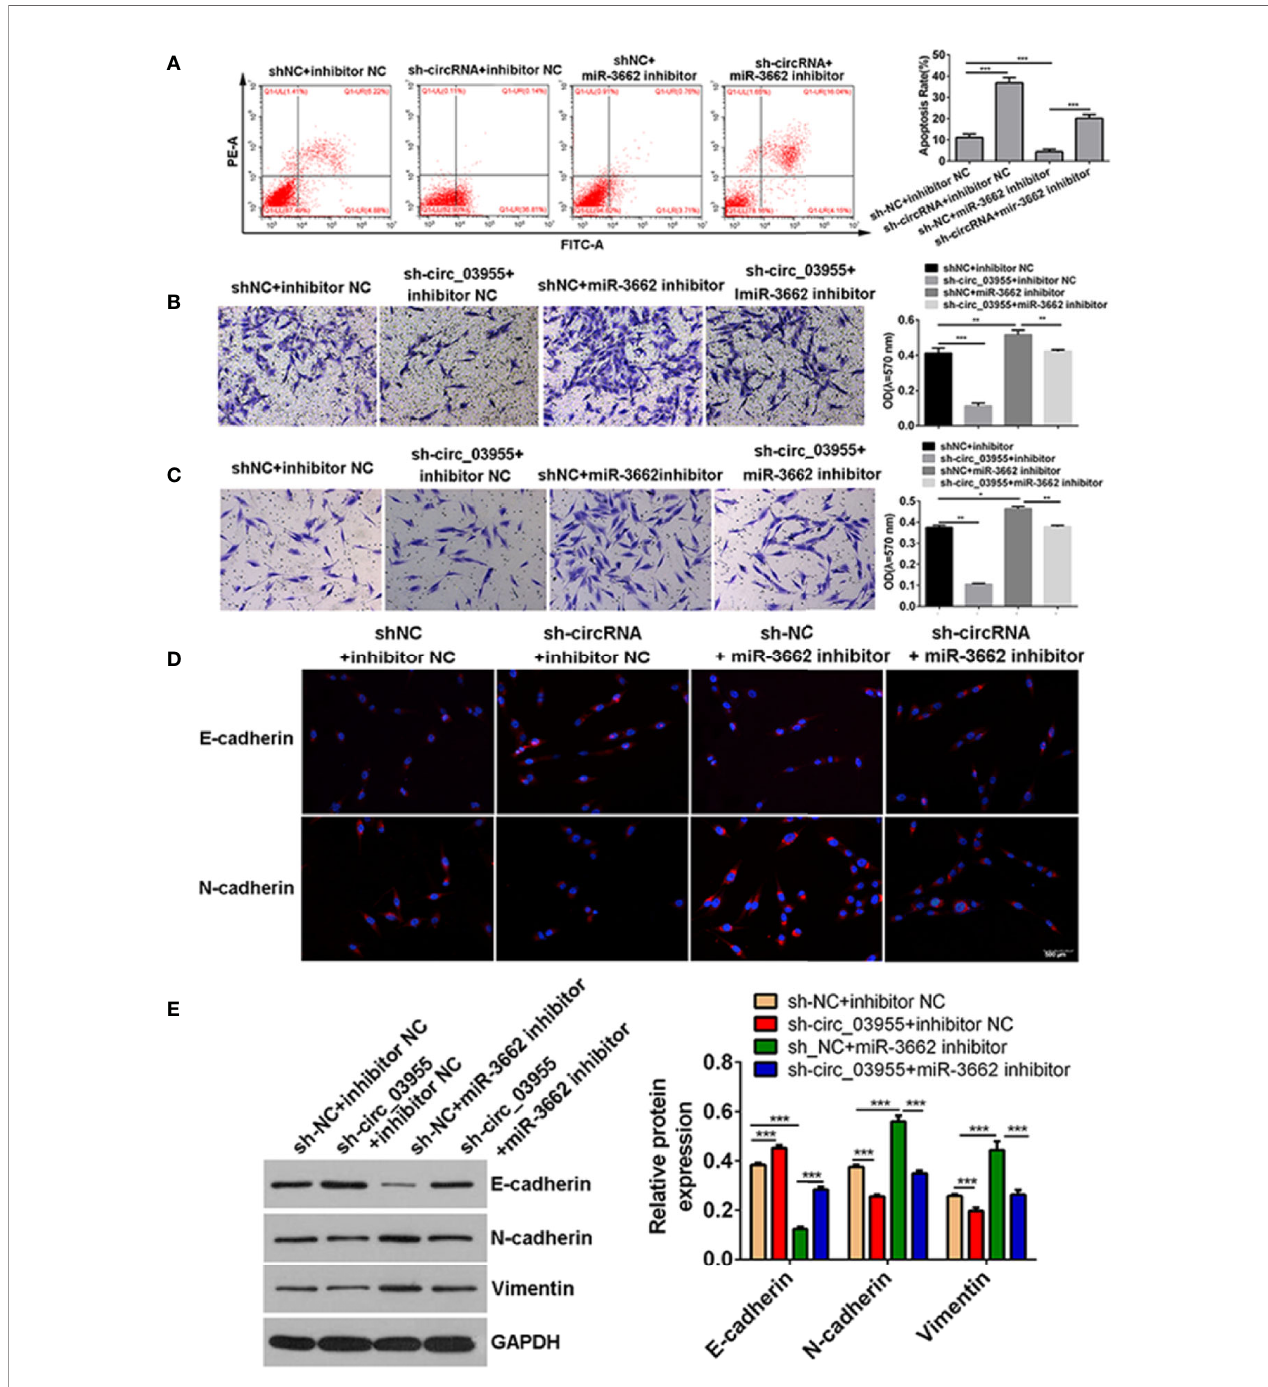
FIGURE 6 | shcirc_03955 rescues the inhibitory effect of miR-3662 on osteosarcoma cells. (A) Flow cytometry was used to detect the apoptotic rate of the four groups in the recovery experiment and to verify that miR-3662 could reverse the apoptotic effect of circ-03955 on osteosarcoma cells. (B) Transwell assay was used to detect the migration offour groups in the recovery experiment and to verify that miR-3662 could reverse the migration effect of circ-03955 on osteosarcoma cells. (C) Transwell assay was used to detect the invasion of the four groups in the recovery experiment and to verify that miR-3662 could reverse the invasion effect of circ-03955 on osteosarcoma cells. (D) The expression of E-cadherin and N-cadherin proteins in four groups was detected by immuno fl uorescence assay. (Scale bar = 500 m m). (E) Western blotting was used to detect the expression of EMT-related proteins (E-cadherin, N-cadherin, and Vimentin) in four groups and to verify that miR-3662 could reverse the effect of circ-03955 on the EMT of osteosarcoma cells. *** P < 0.001 indicated that the difference has statistical signi fi cance. Data are presented as the mean ± standard deviation of three independent experiments, * p < 0.05, ** p < 0.01, *** p < 0.001. The red color indicates the expression of the target protein, and the blue color indicates the nuclear staining. The magni fi cation is